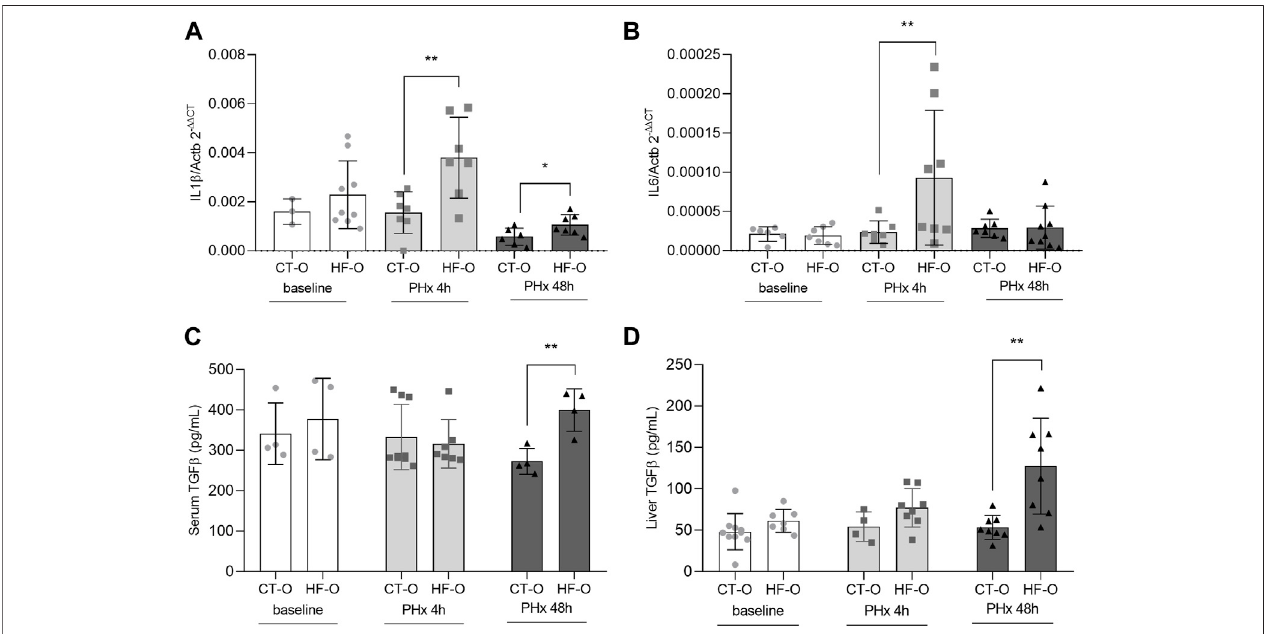
FIGURE 1 | In fl ammatorymarkers of the offspring of control and obese dams after partial hepatectomy. Hepatic IL1 β (A) and IL6 (B) gene expression (qPCR), serumTGF β (C) andliverTGF β (D) proteincontent(ELISA)fromtheoffspringofcontrol(CT-O)andobese(HF-O)dams,before(baseline)orafter4(PHx4h)or48h(PHx 48 h) of partial hepatectomy surgery. Data are plotted as individual values (dot plots), means and SEM, represented by vertical bars. n = 3 – 9/group. ** p ≤ 0.005 after Student ’ s t-test (CT-O versus HF-O).